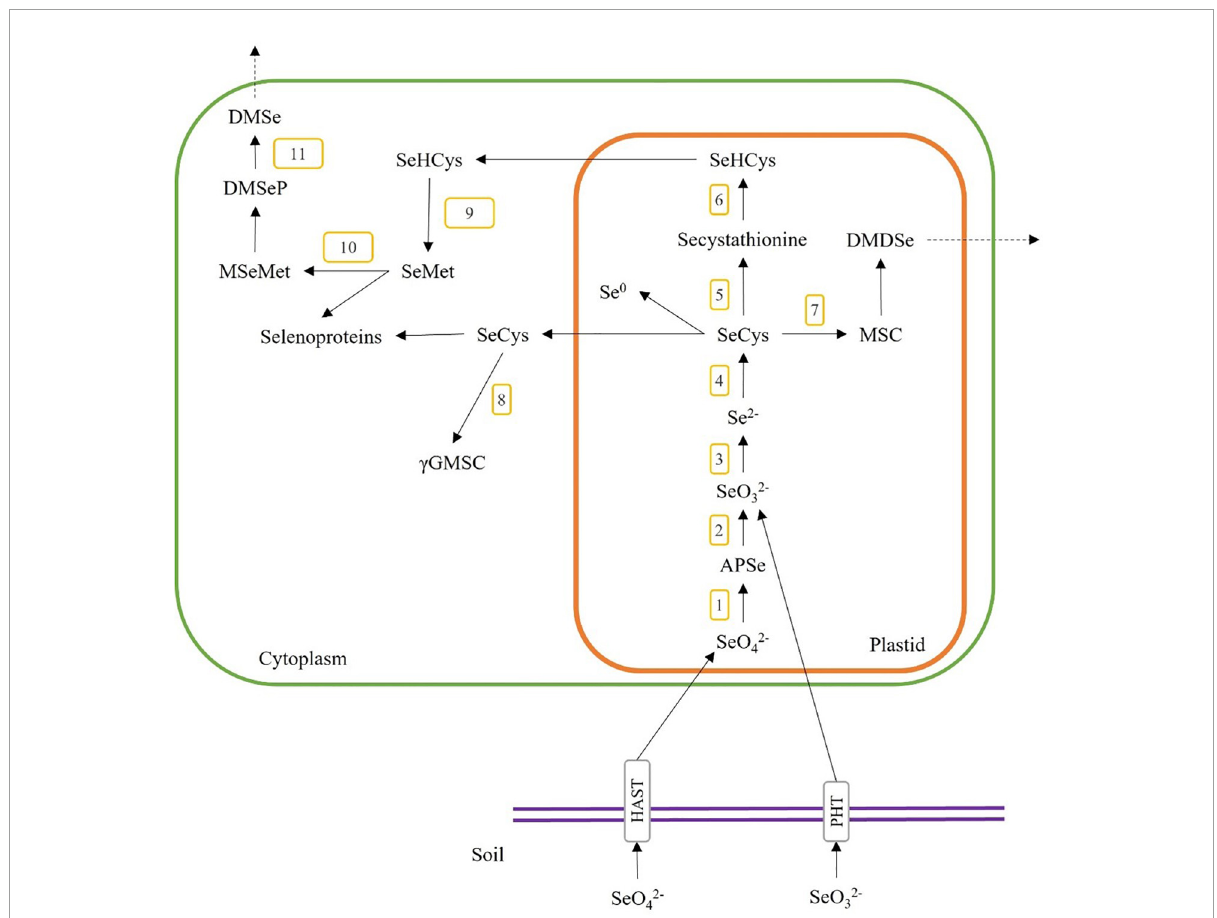
FIGURE2 A general overview of Se uptake, metabolism, and incorporation in higher plants. The numbers 1–12 indicate the possible enzymatic steps involved in the conversion of selenite and selenate. 1, ATP sulfurylase; 2, adenosine phosphosulfate reductase; 3, sulfite reductase; 4, O-acetylserine thiol-lyase; 5, cystathionine- γ -synthase; 6, cystathionine- β -lyase; 7, selenocysteine-lyase; 8, γ -glutamyl-cysteine synthetase; 9, methionine synthase; 10, methionine methyltransferase; 11, dimethyl selenoproprionate-lyase; SeO 2 − 4 , selenate; SeO 2 − 3 , selenite; APSe, adenosine 5 (cid:48) -phosphoselenate; SeCys, selenocysteine; MSC, Se-methylselenocysteine; DMDSe, dimethyldiselenide; SeHCys, selenohomocysteine; Se 0 , elemental selenium; γ GMSC, γ -glutamyl-methylselenocysteine; SeMet, selenomethionine; MSeMet, methyl-selenomethionine; DMSeP, dimethylselenoproprionate; DMSe, dimethyl